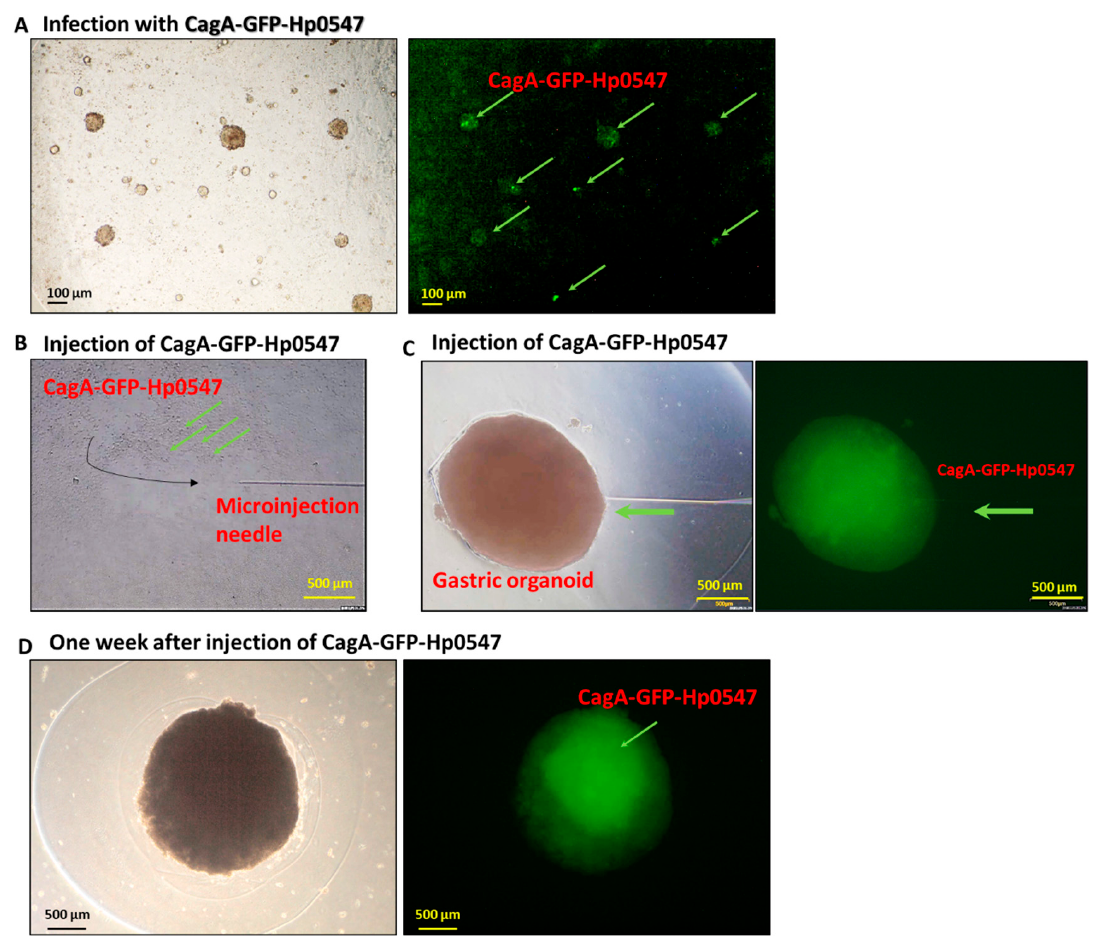
Figure 1. Comparative infection and microinjection of H. pylori into human gastric organoids and traced by green fluorescence protein signaling. ( A ) CagA-green fluorescence protein (GFP)-labeled H. pylori Hp0547 (CagA-GFP-Hp0547)-infected organoids were cultured for 24 h at a multiplicity of infection (MOI) of 200 and their signals were traced by fluorescence microscopy. Brightfield image (left panel) and their CagA-GFP expressed H. pylori Hp0547 image (right panel) are shown. ( B ) CagA-GFP-labeled Hp0547 was microinjected as described in Materials and Methods. The microinjection needle is also indicated. ( C ) Brightfield image of CagA-GFP-labeled Hp0547-infected organoids and their detection of GFP signal by CagA-GFP-Hp0549. ( D ) Brightfield image and GFP detection of CagA-GFP-Hp0549 after culture for 1 week. Scale bars indicated in each panel. Arrow indicates GFP signal from CagA-GFP